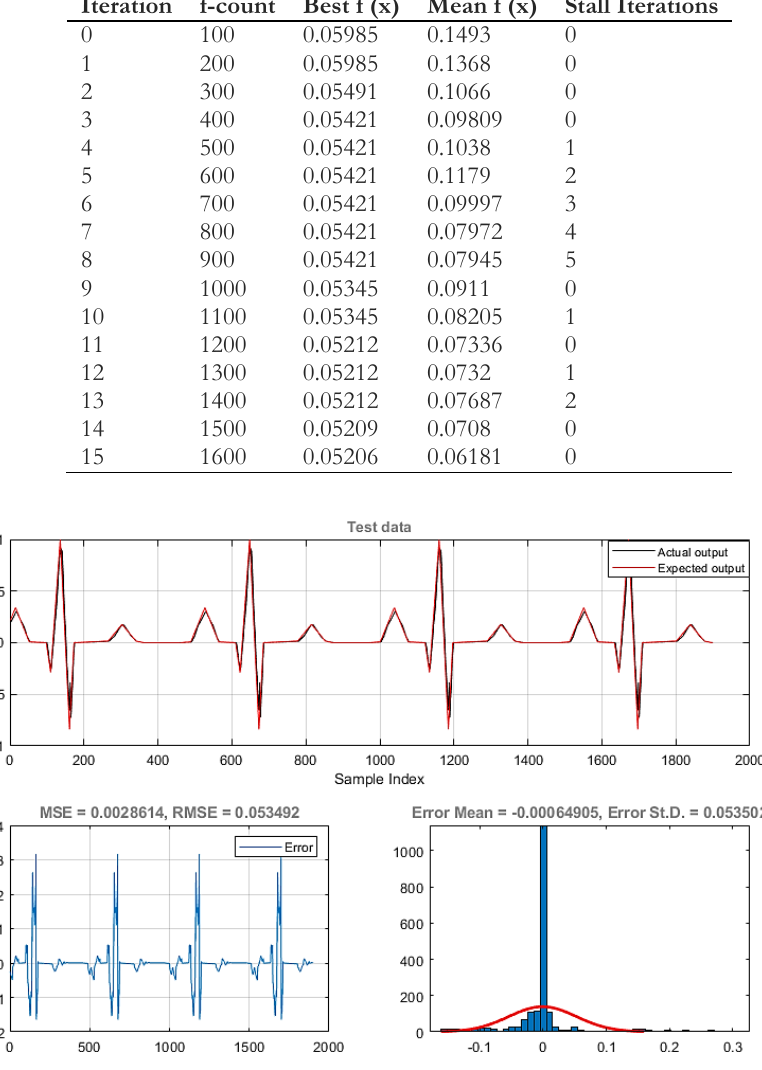
Fig. 6. The result of the actual, expected, error, and error histogram obtained with optimized upper and lower MFs of